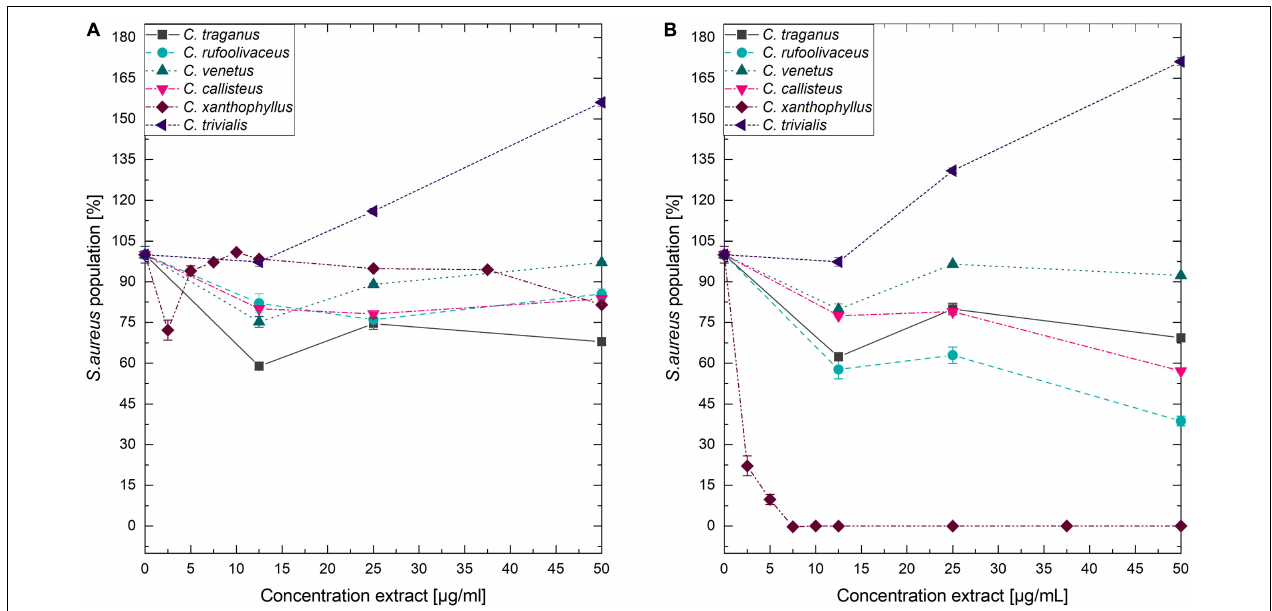
FIGURE 8 | Dose–response curves of S. aureus treated with Cortinarius extracts. (A) Growth inhibition under dark conditions. (B) Growth inhibition under irradiation conditions ( λ = 478 nm, H = 30 J/cm 2 , PI = 60 min).